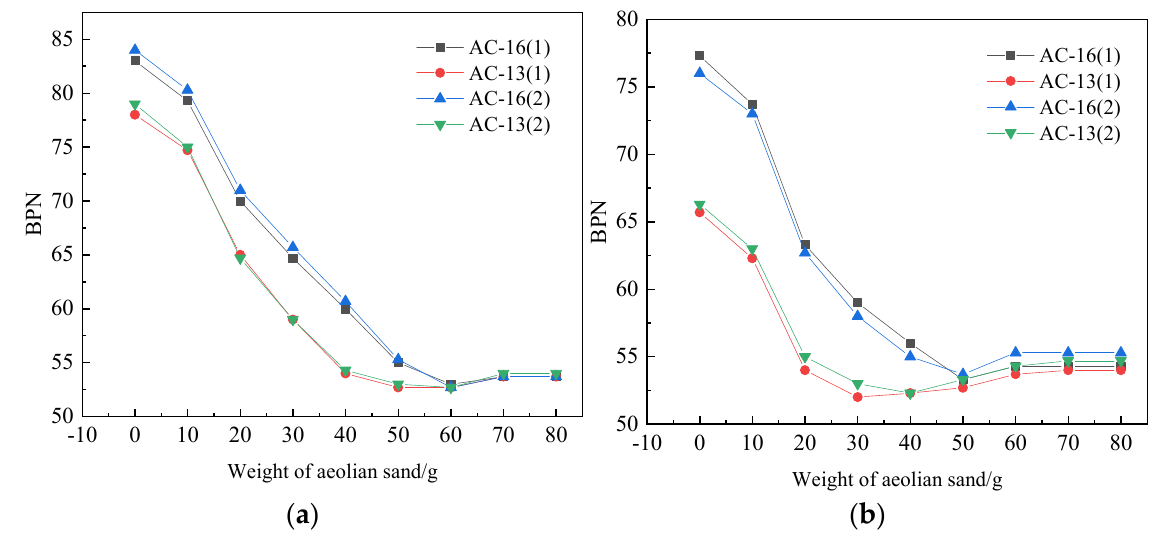
Figure 10. BPN under different sediment accumulation conditions in the wet state. ( a ) The moisture content of accumulated sand is 5%; ( b ) The moisture content of accumulated sand is